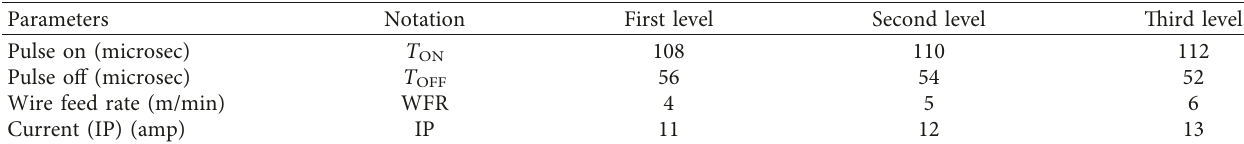
Table 3: Input levels of the various input process parameters.